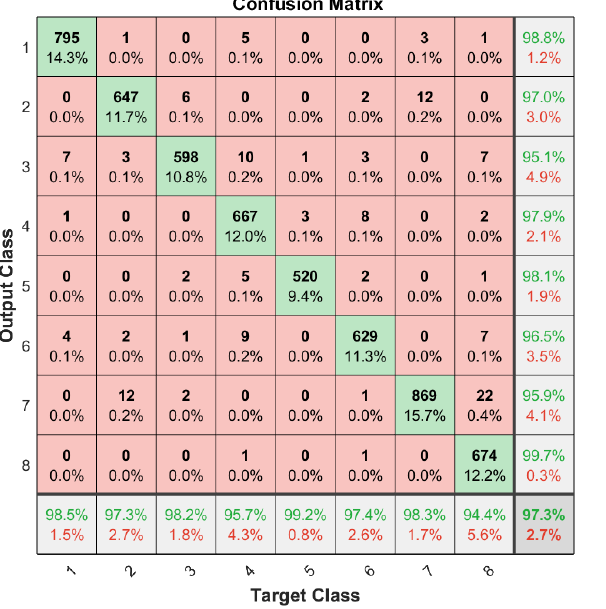
Figure 13. Confusion matrix generated using the CNN algorithm.